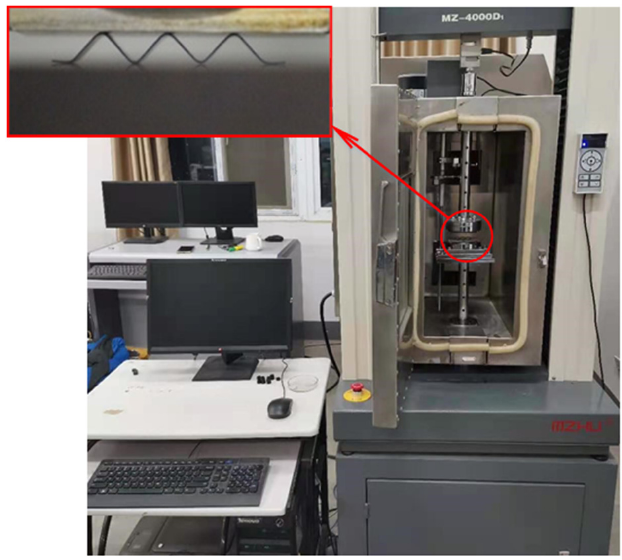
Figure 4. Mechanical property testing